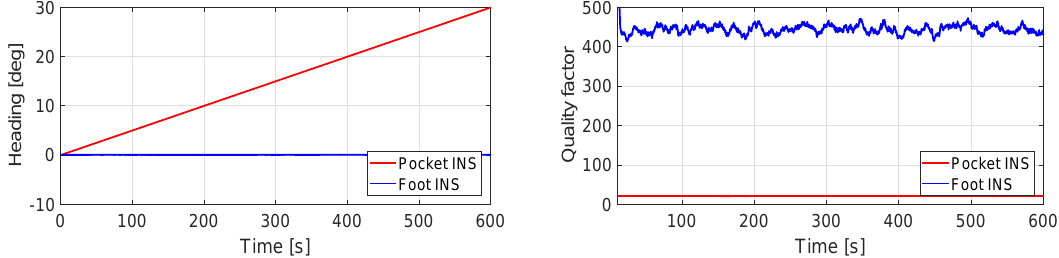
Figure 9. ( Left ) Heading estimation of the pocket INS and the foot INS of a still IMU. The turn rate measurements to the pocket INS have a 0.05 ◦ /s constant bias in the z -axis. The turn rate measurements to the foot INS have no bias; ( Right ) Quality factor estimation of the heading estimations.